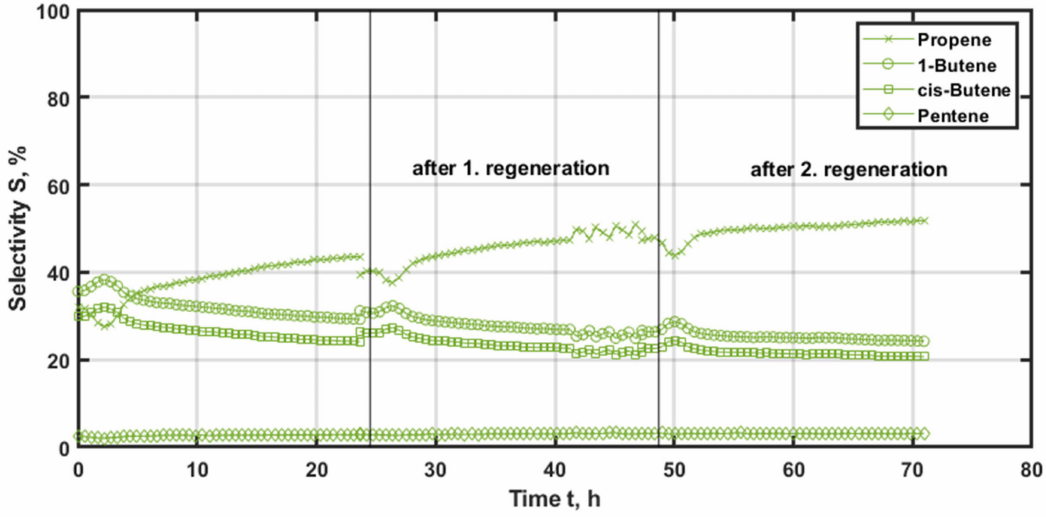
Figure 11. Selectivity of the main reaction products with time-on-stream (TOS) applying W/SiO 2 as the catalyst at 600 ◦ C and 500 kg cat · s · m − 3 , with regeneration at 500 ◦ C and 20% oxygen for 3 h. In contrast, the selectivity of the byproducts 1-butene, cis-butene and pentene are